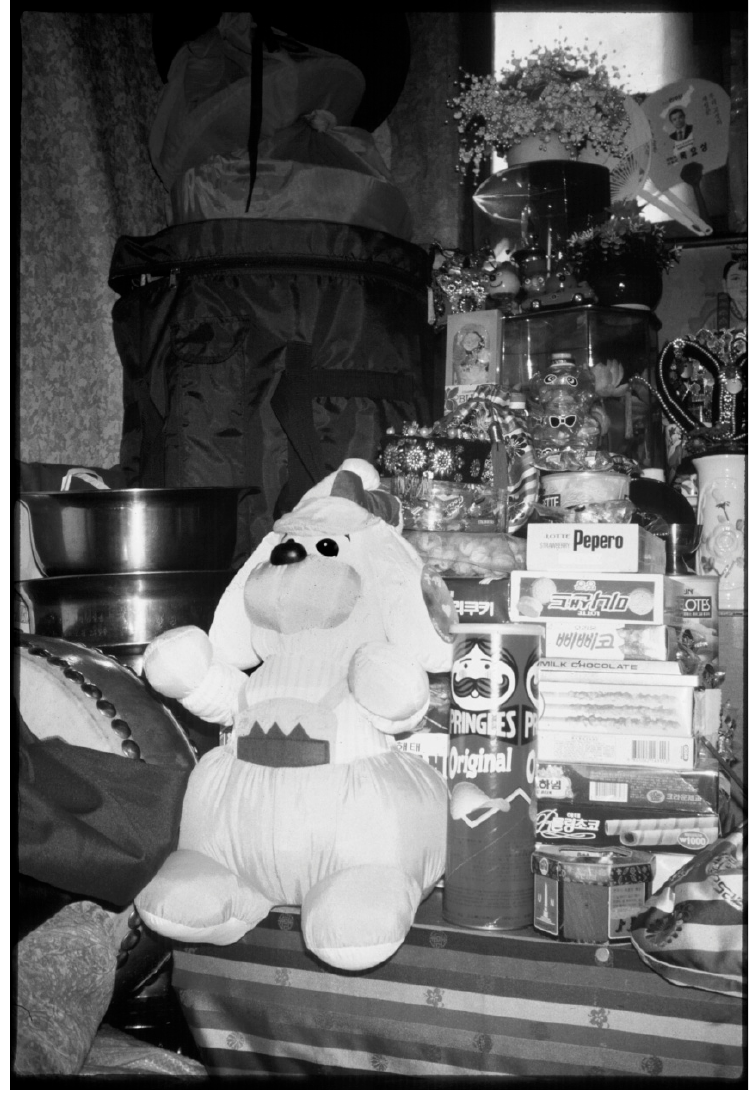
Figure 7. Idiosyncratic offerings for the Child Gods and, on top, a flowery headpiece for Princess Hogu, the early 1990s. Photograph by author.